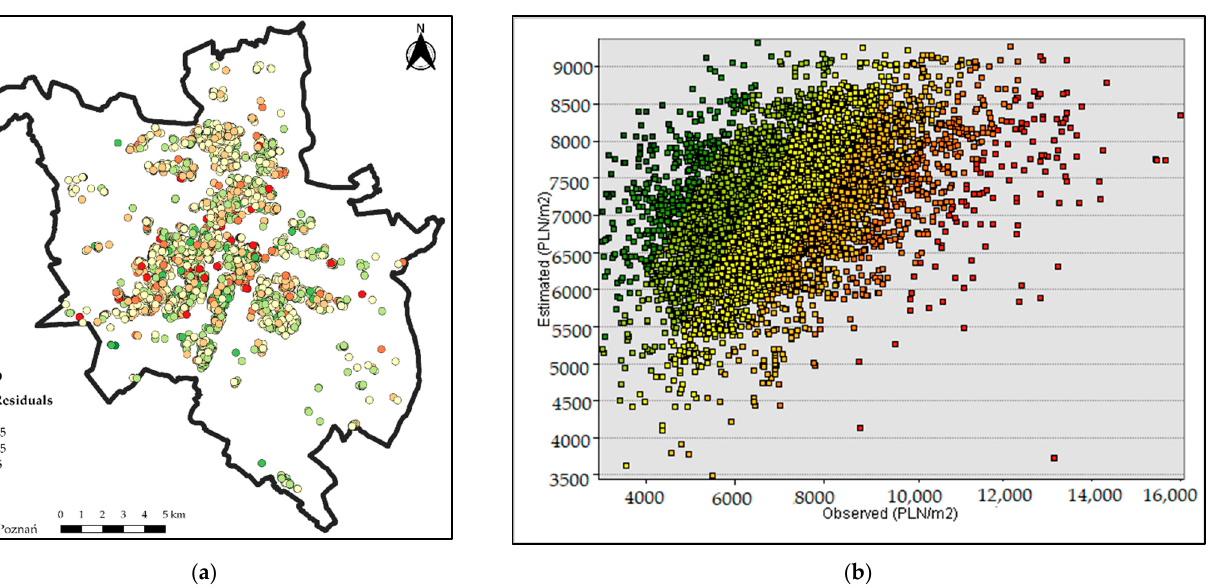
Figure 4. ( a ) OLS standard residuals. ( b ) Difference between the observed and estimated values.